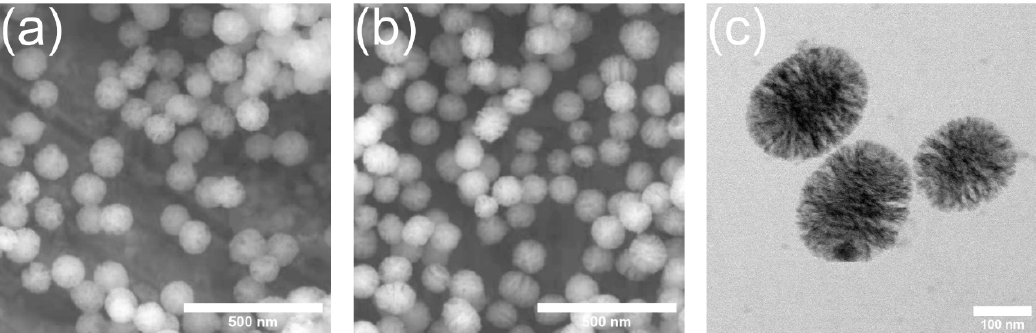
Figure 1. Particle morphology of MBGs ( a ), Zn-MBGs ( b ) in SEM images and Zn-MBGs ( c ) in TEM images.